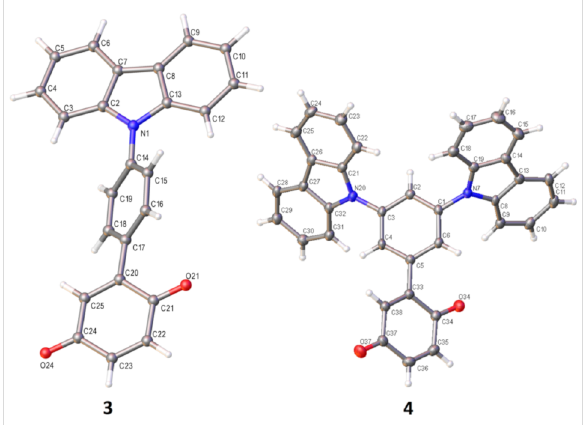
Figure 2: Crystal structures of 3 and 4